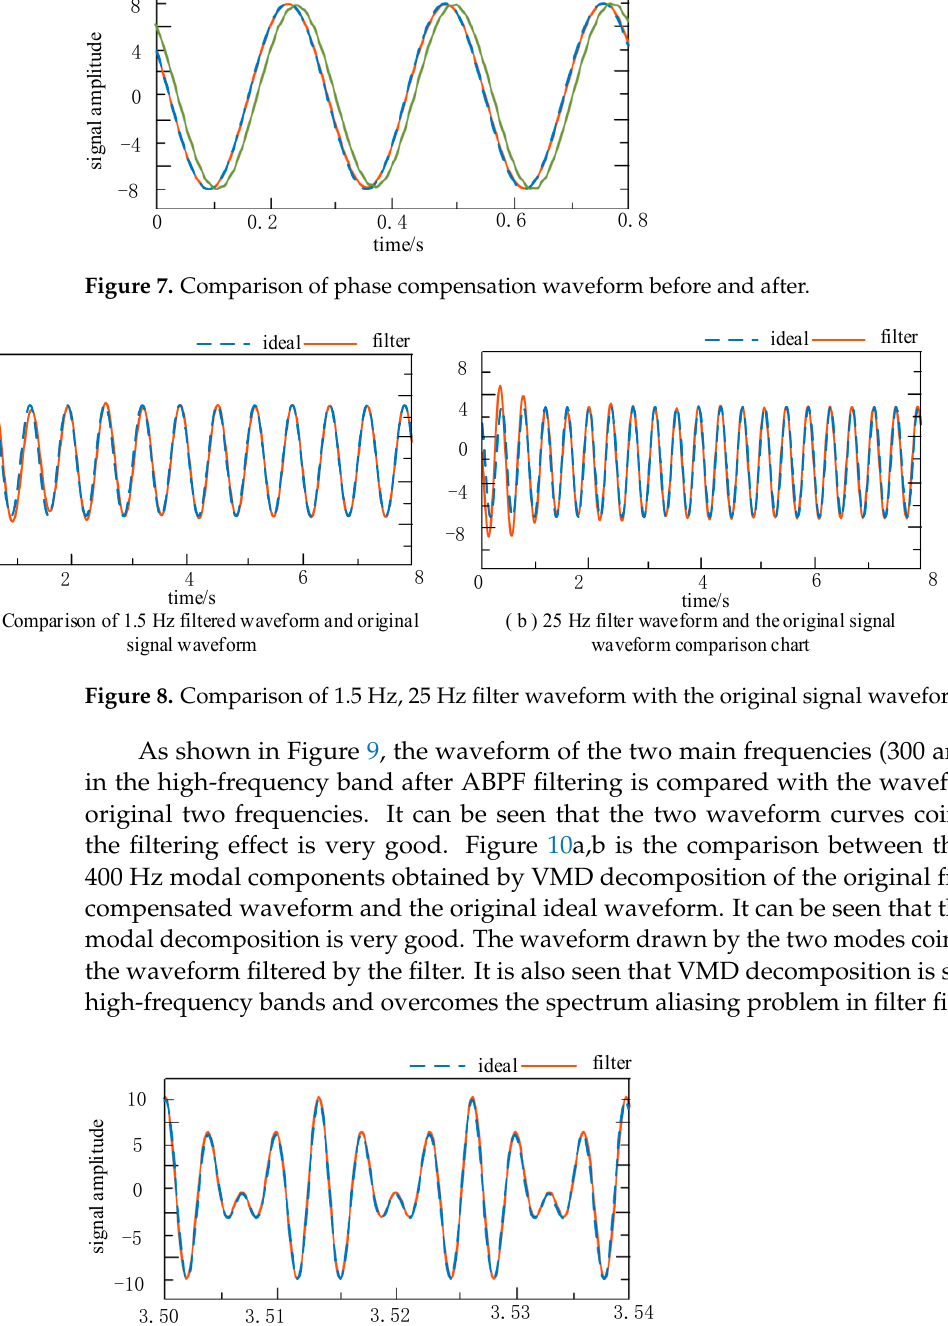
Figure 6. Comparison of each signal before and after wavelet denoising.